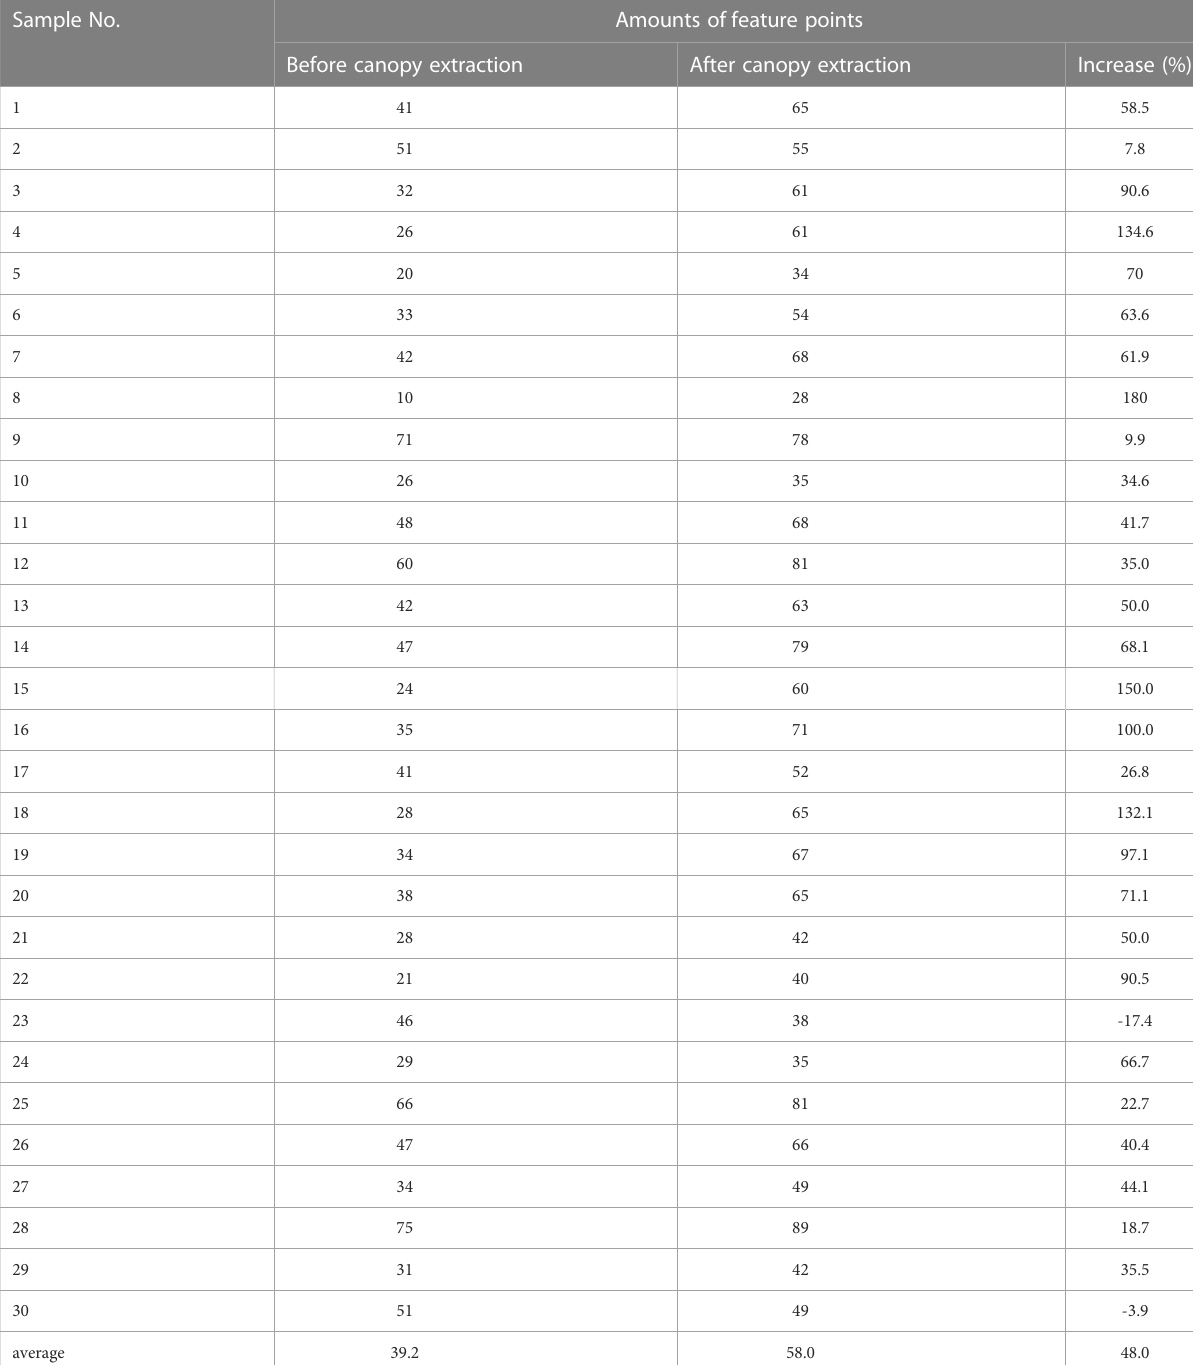
TABLE 1 Comparison of the results of feature detection before and after canopy extraction in ten samples. Sample